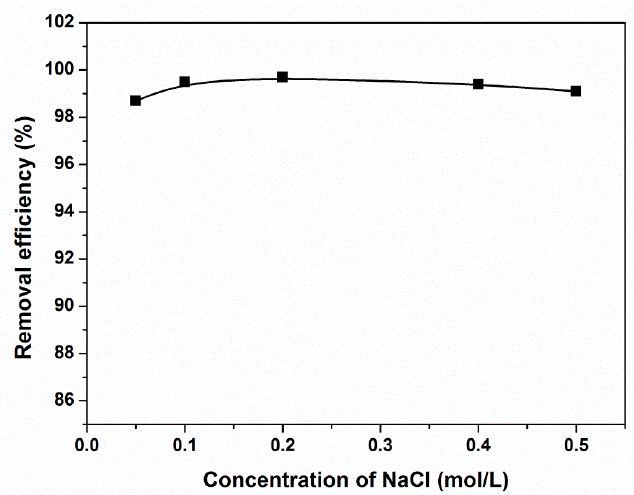
Figure 8. Effect of ionic strength on the removal of CR by PGMA-g-PPy. (Adsorbent dose, 28.5 mg; volume, 6 mL; initial concentration, 500 mg/L; pH, 7.0; contact time, 1 h.)